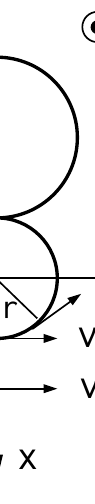
Fig. 10. Particle trajectory at the front of a